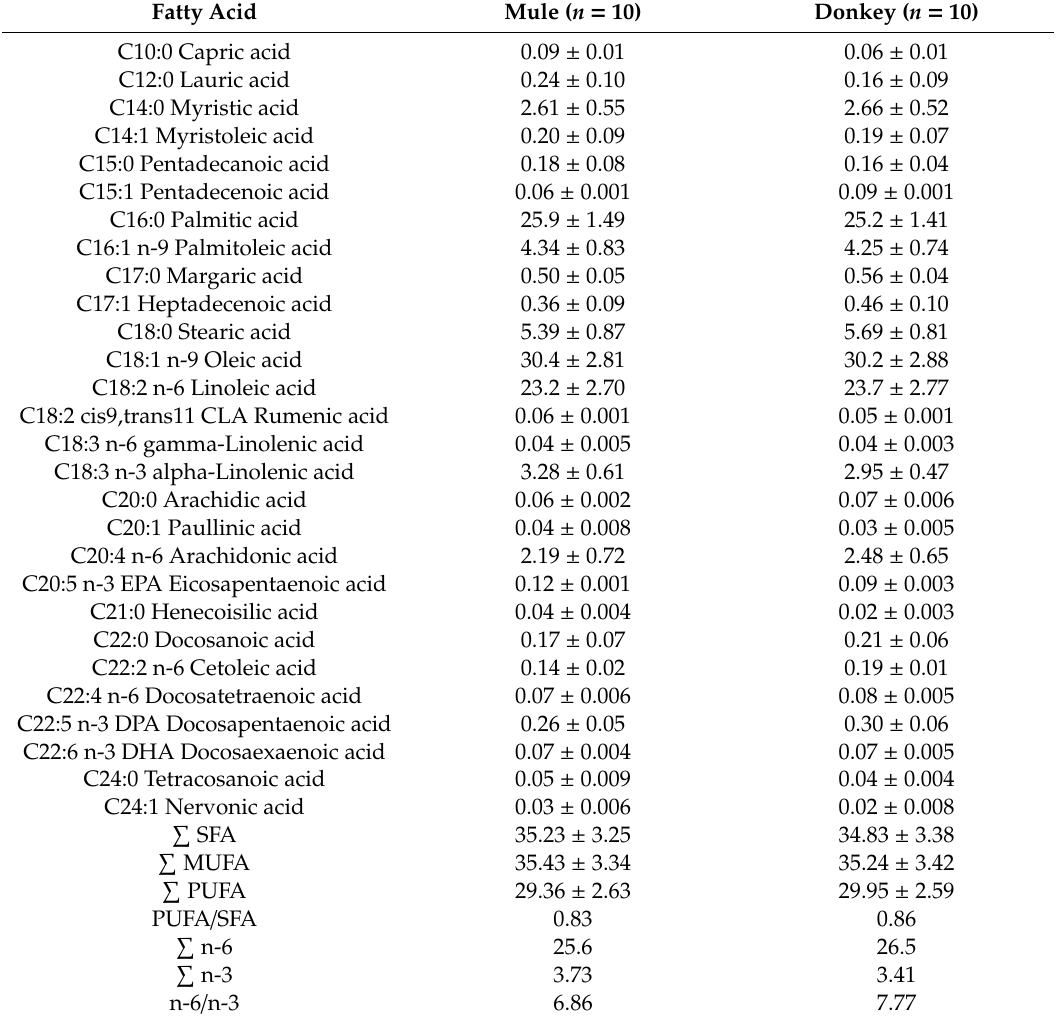
Table 3. Fatty acid composition (% total fatty acids) determined in the Longissimus thoracis muscles of mules and donkeys (means ±